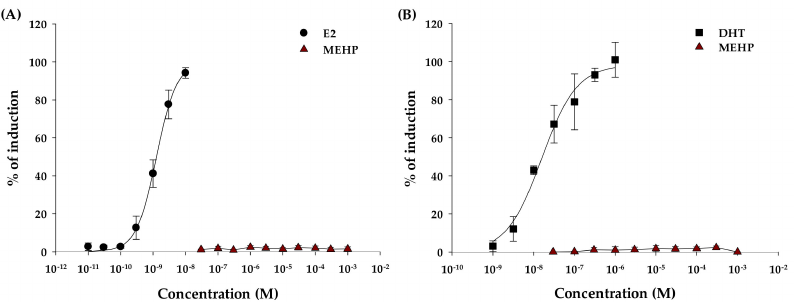
Figure 2. Sigmoidal dose-response curves for the agonistic potential of MEHP on estrogen ( A ) and androgen ( B ) receptor activity,